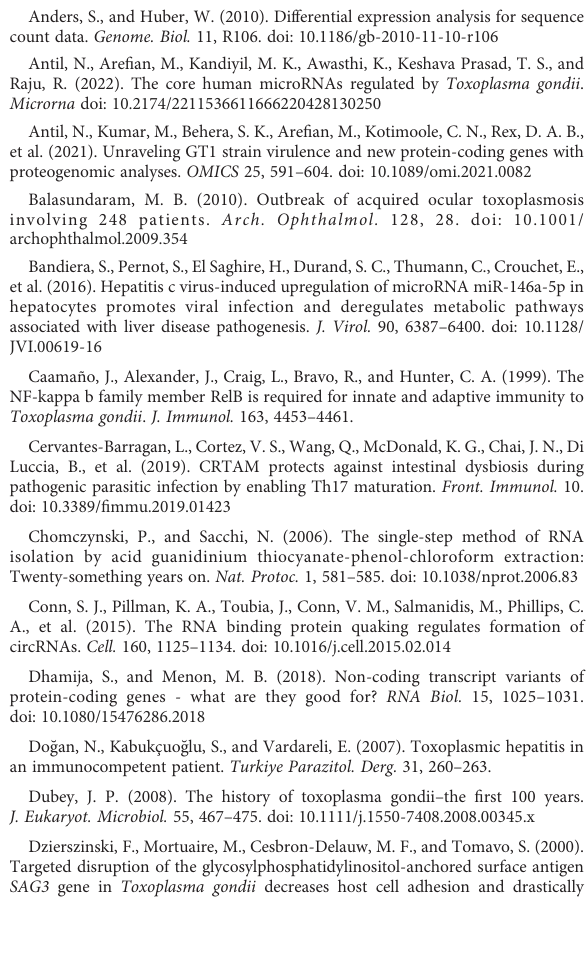
SUPPLEMENTARY FIGURE 1 Validation for the expression of the DEcircRNAs and DEmiRNAs by qRT- PCR at acute infection (AI) and chronic infection (CI) stages. SUPPLEMENTARY TABLE 1 The expression pro fi le of differentially expressed circRNAs and miRNAs in the liver at acute infection and chronic infection stages. SUPPLEMENTARY TABLE 2 The data of DEcircRNA-DEmiRNA network